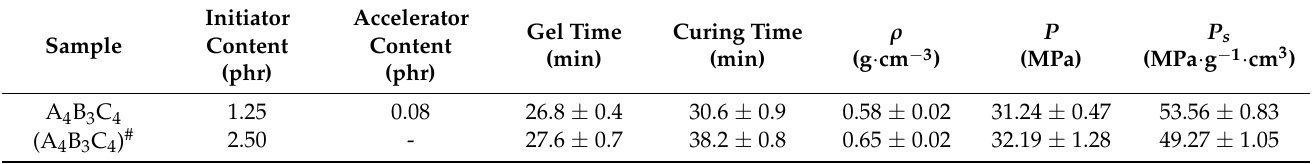
Table 7. Parameter comparison between A 4 B 3 C 4 and (A 4 B 3 C 4 ) #